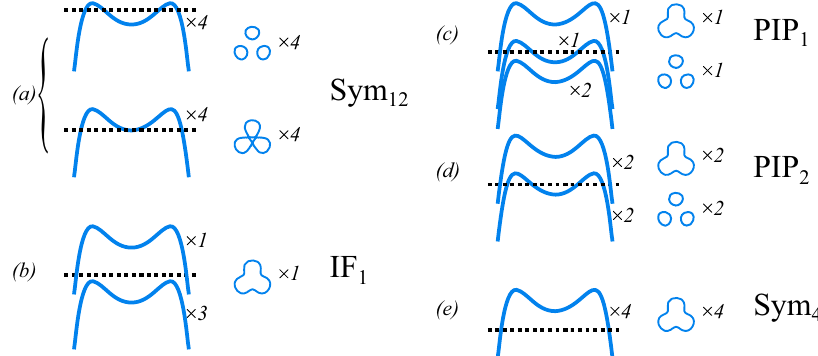
Fig. 2 Landau free energy. The functions f l ( x , y ) from Eq. (4), with l = i, ii, iii, shown as functions of x ¼ γ = (panel ( a )) and y = 1 (panel ( b )). The free energies are F l = ( α 2 / β ) f l ( x , y ), hence the smallest f l ( x , y ) determines the ground state. The states (i) and (ii) are the ones for which the vH peaks split in 3-1 (1-3) and 2-2 fashion, respectively. The state (iii) is an intermediate state with 2-1-1 (1-1-2) splitting. This intermediate state does not appear as a ground state in our model for all y , but its energy is close to those of (i) and (ii) near critical x of the fi rst-order transition between the two, and it can potentially become a ground state around this x if we move away from SU (4)- symmetric model by, e.g., including interaction terms with inter-valley scattering. The relation between x and ∣ n ∣ is shown at the